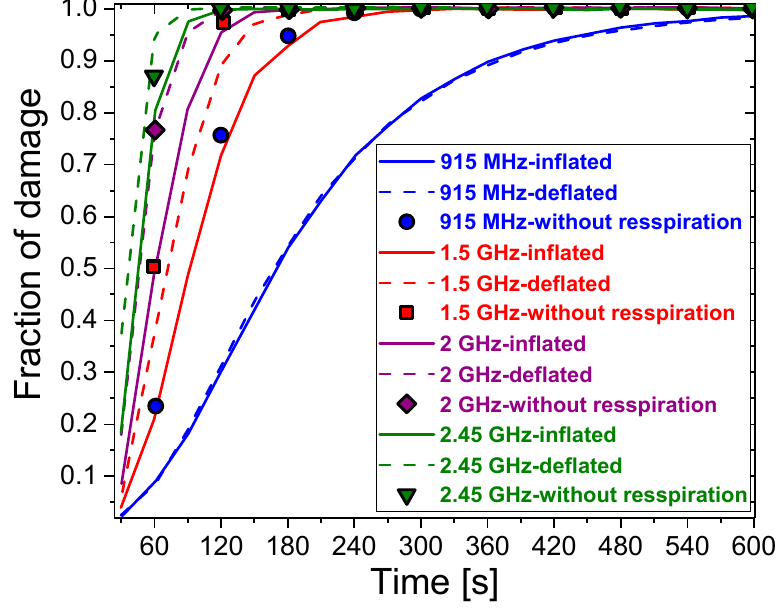
Figure 9. The necrotic tissue during ablation time for inflation (solid curves), deflation (dash curves), and regardless of respiration (symbols) of the lungs, exposed to microwave frequencies 915 MHz and 2.45 between 915 MHz and 2.45 GHz.